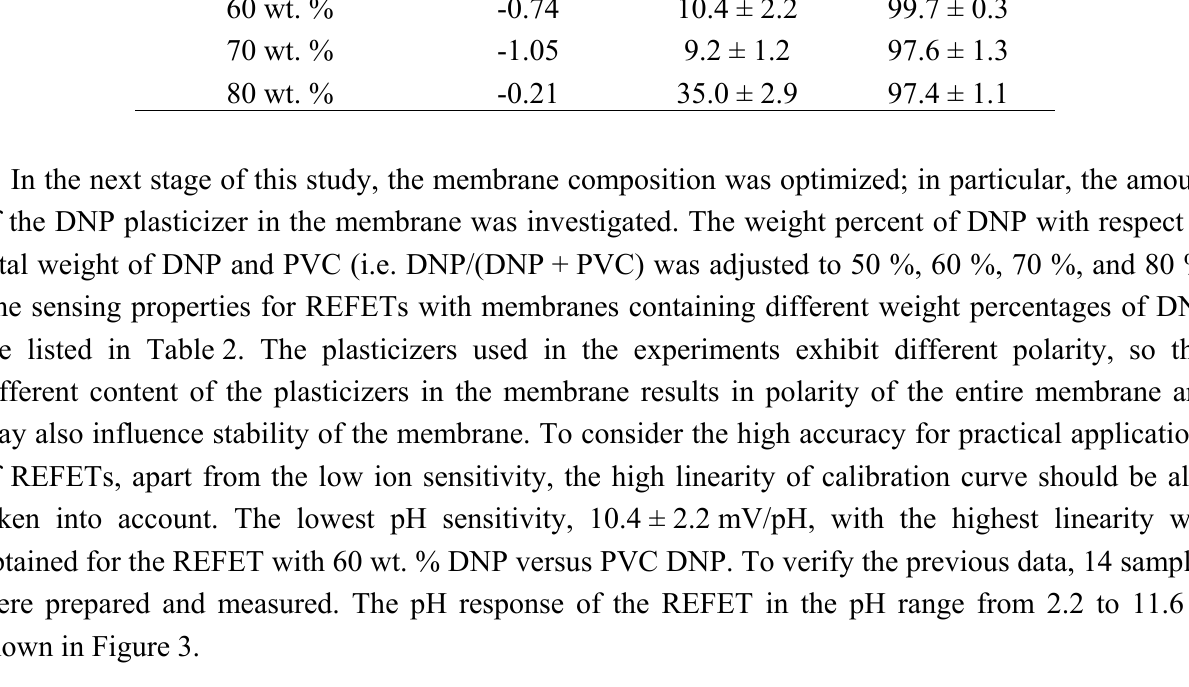
N ISFET without a PVC membrane, and REFETs with 3 4